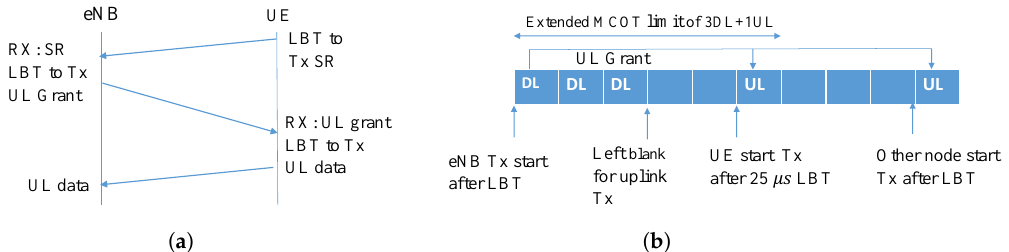
Figure 3. NR-U listen before talk (LBT) and shared maximum channel occupancy time (MCOT). SR, scheduling request. ( a ) NR-U LBT channel access procedure; ( b ) Shared